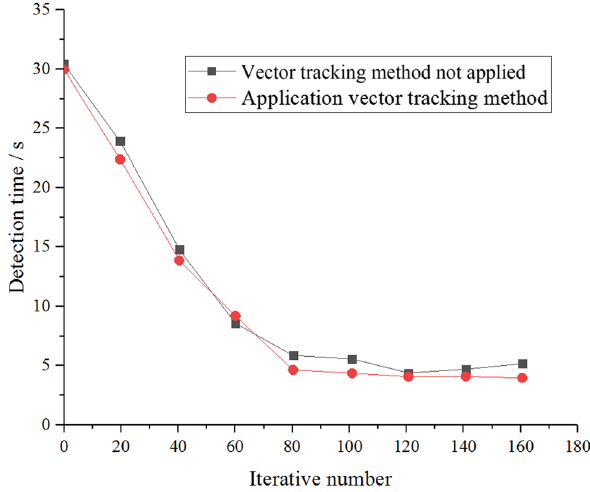
Figure 3: Time comparison result.